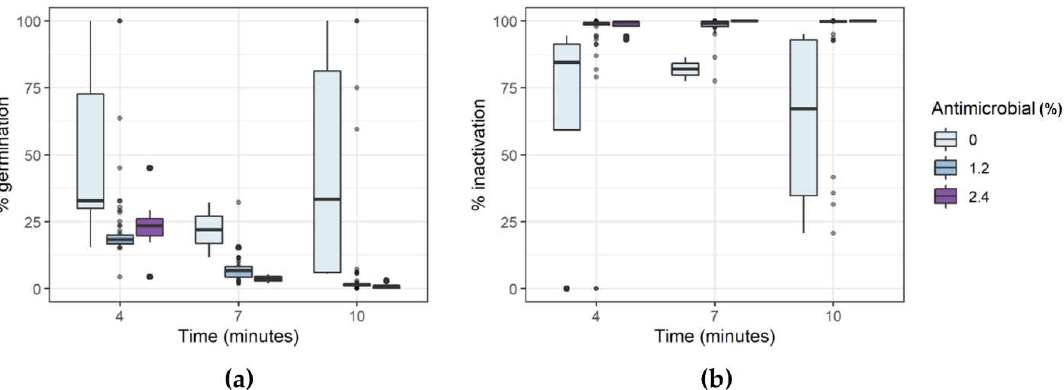
Figure 2. Percentage variation of germination ( a ) and inactivation ( b ) of A. acidoterrestris LMG 16906 spores after exposure to DoE conditions.